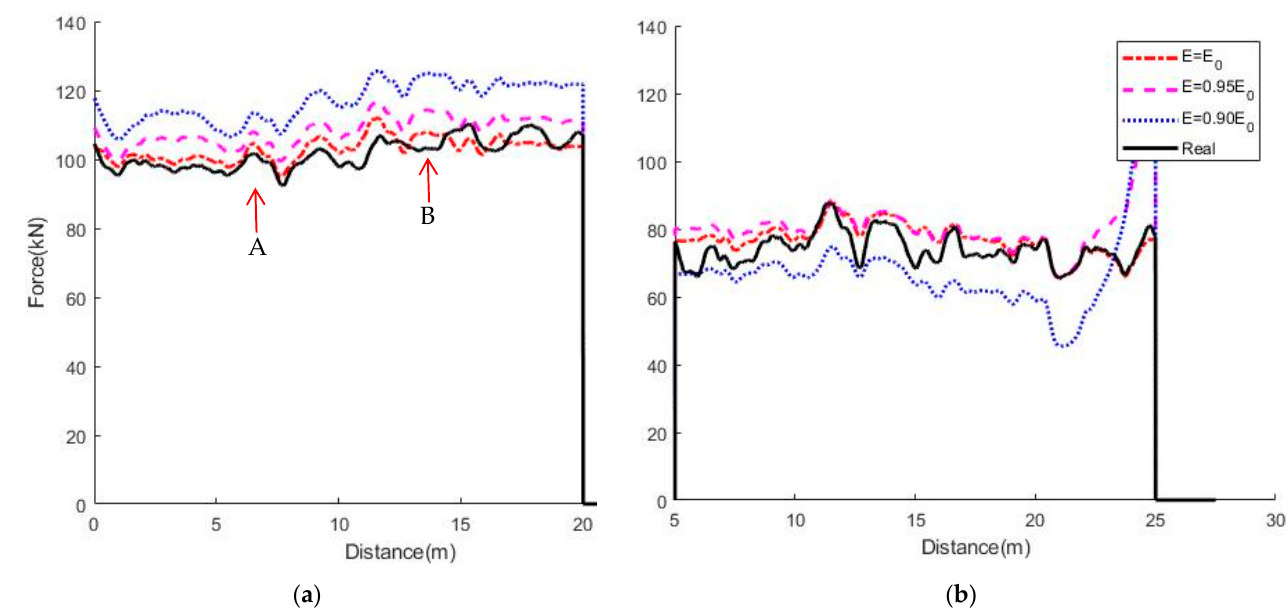
Figure 7. MFI results with 5% and 10% global damage levels for; ( a ) first axle; and ( b ) second axle.